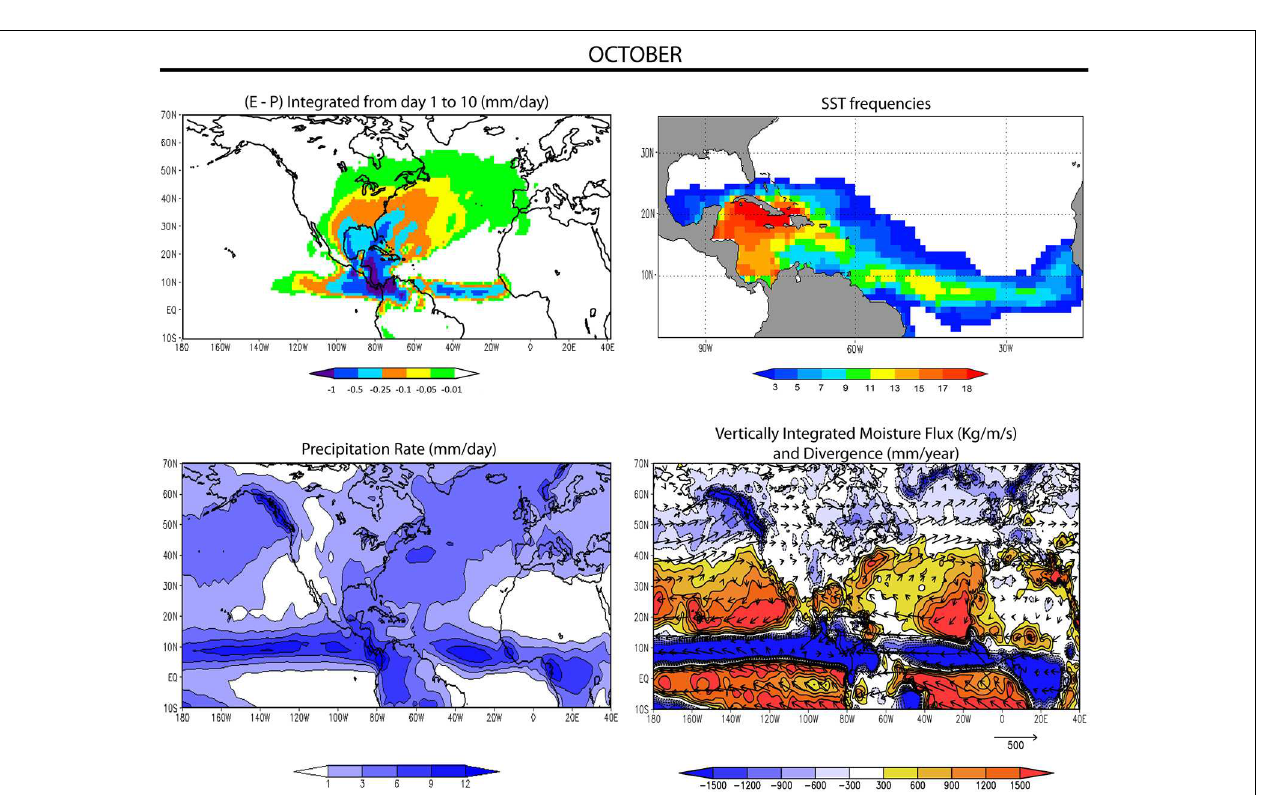
FIGURE 6 | As Figure 1, for